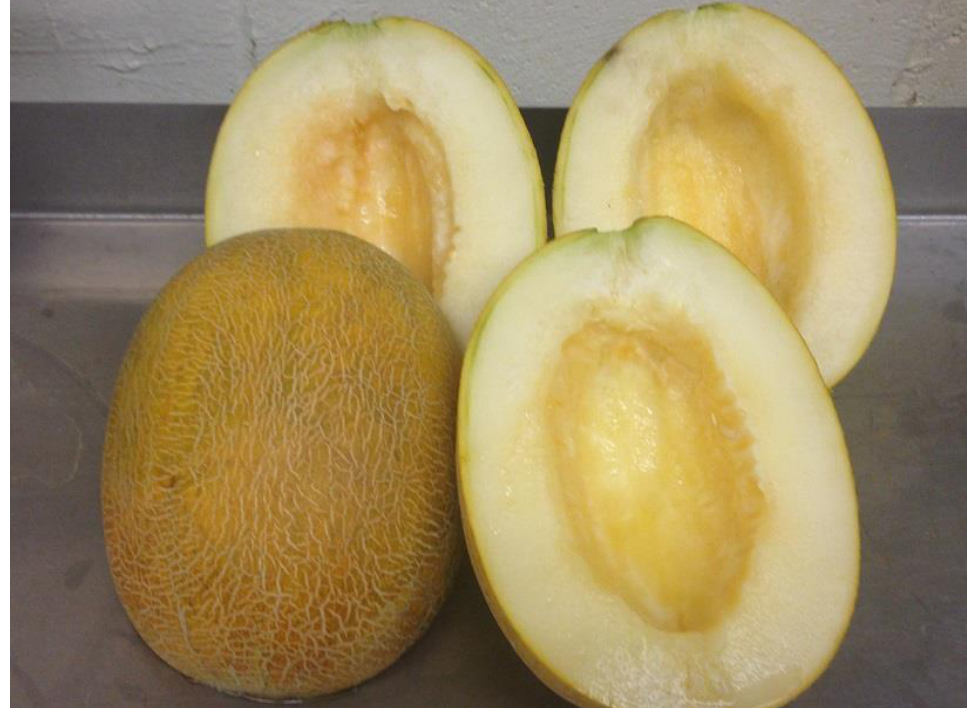
Figure 3. ‘Rasmouka Ananas’ cut fruit to show rind pattern and color, as well as its attractive interior fruit color.